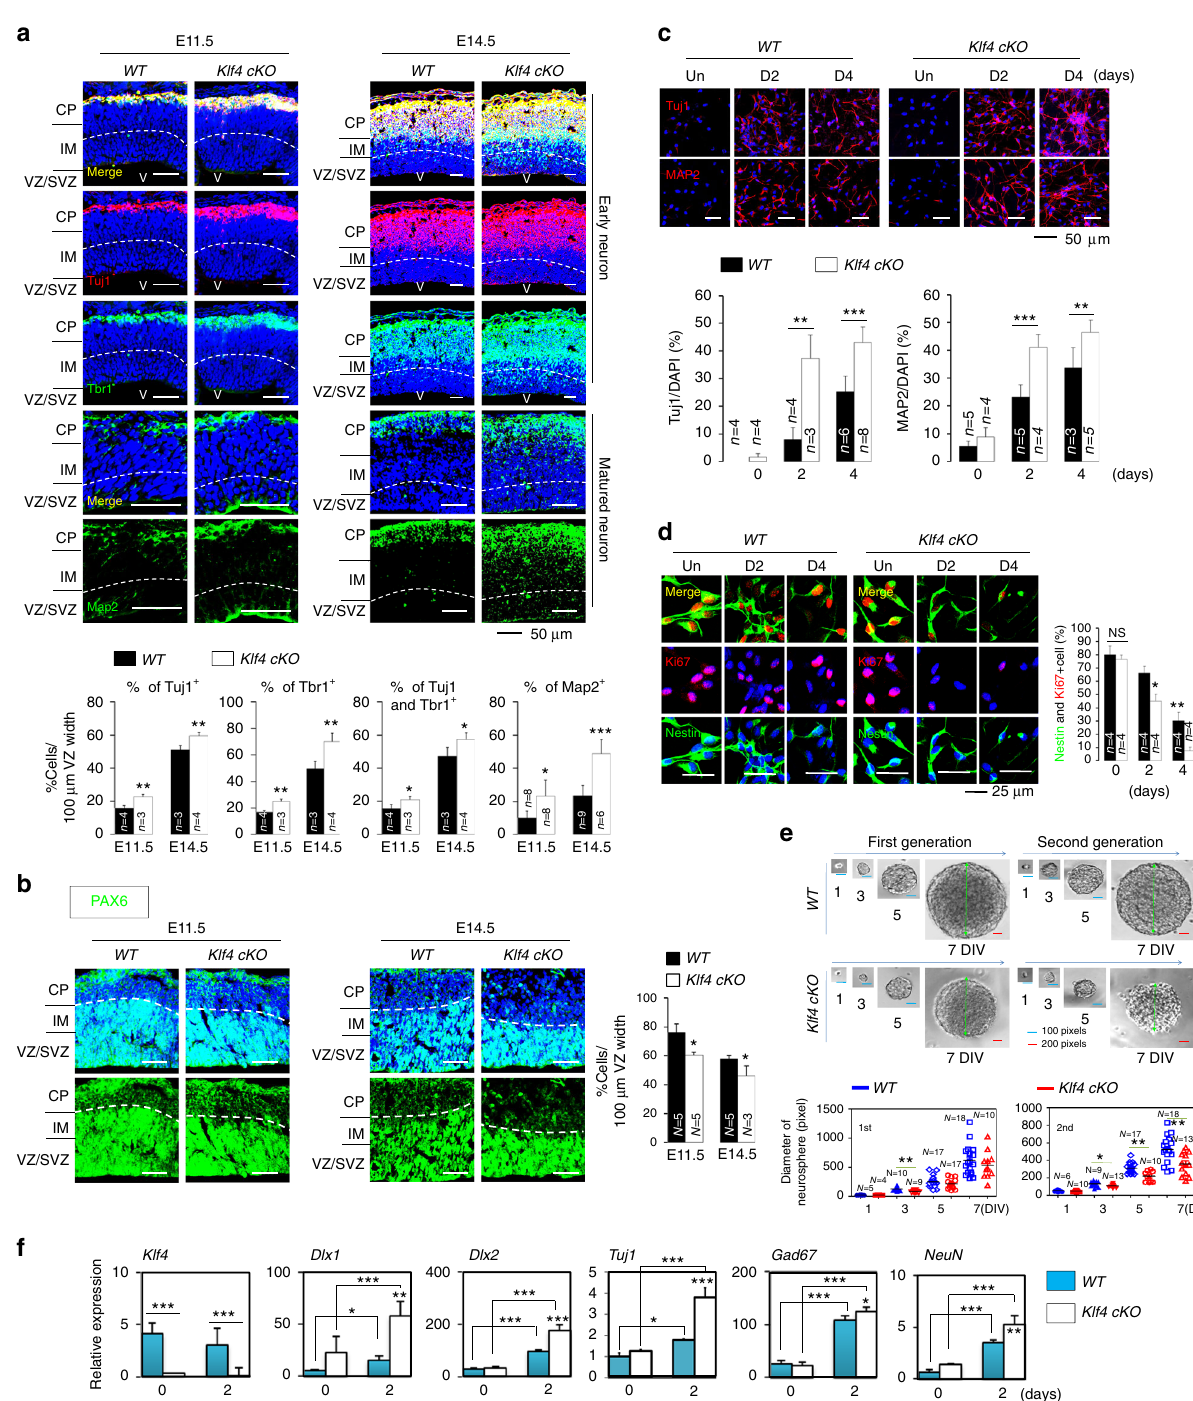
Fig. 1 Klf4 down-regulation enhances neurogenesis in vivo and in vitro. a (Upper) Fixed coronal sections from E11.5 (left) or E14.5 (right) mouse forebrain stained with antibodies against Tuj1 (red), Tbr1 (green), or Map2 (green). Nuclear staining is shown by DAPI (blue). (Lower) Quanti fi cation of data shown above (E11.5: Klf4 fl / + ( WT ), n = 4 – 8, Klf4 conditional knockout ( cKO ), n = 3 – 8, and E14.5: Klf4 fl / + ( WT ), n = 3 – 9, Klf4 cKO , n = 4 – 6). Scale bars, 50 μ m. b (Left) Analysis of Pax6 in sections described in a . Scale bar, 50 μ m. (Right) Quanti fi cation of data shown on the left (E11.5: WT , n = 5, Klf4 cKO , n = 5, and E14.5: WT , n = 5, Klf4 cKO , n = 3). c (Upper) Immunostaining with Tuj1 or Map2 (both red) antibodies in WT and Klf4 cKO NPCs in undifferentiation and differentiation conditions. Nuclear staining is shown by DAPI (blue). Scale bars, 50 μ m. (Lower) Quanti fi cation of Tuj1-positive ( WT -Un, n = 4, WT -D2, n = 4, WT -D4, n = 6, Klf4 cKO -Un, n = 4, Klf4 cKO -D2, n = 3, Klf4 cKO -D4, n = 8) and Map2-positive ( WT -Un, n = 5, WT -D2, n = 5, WT -D4, n = 3, Klf4 cKO -Un, n = 4, Klf4 cKO -D2, n = 4, Klf4 cKO -D4, n = 5) cells in panels above. d Immunostaining with Ki67 (red) and Nestin (green) antibodies in WT and Klf4 cKO NPCs. DAPI (blue). Scale bars, 25 μ m. (Right) Quanti fi cation of Ki67/Nestin double-positive cells in analysis shown at left ( n = 4). e Single WT and Klf4 cKO NPCs were separated by serial dilution and neurosphere formation was induced for 7 days in vitro (DIV). Relative size of primary spheres grown to 7 DIV was quanti fi ed by Image J Software. Scale bars, blue (100 pixel), red (200 pixel). f qPCR analysis of indicated mRNAs in WT and Klf4 cKO NPCs. Values correspond to mean ± SD. ANOVA tests were performed to calculate signi fi cance (* P < 0.01, ** P < 0.001, *** P < 0.0001). See also Supplementary Fig. 1a – f and Supplementary Table 4. Un undifferentiationn condition, D differentiation